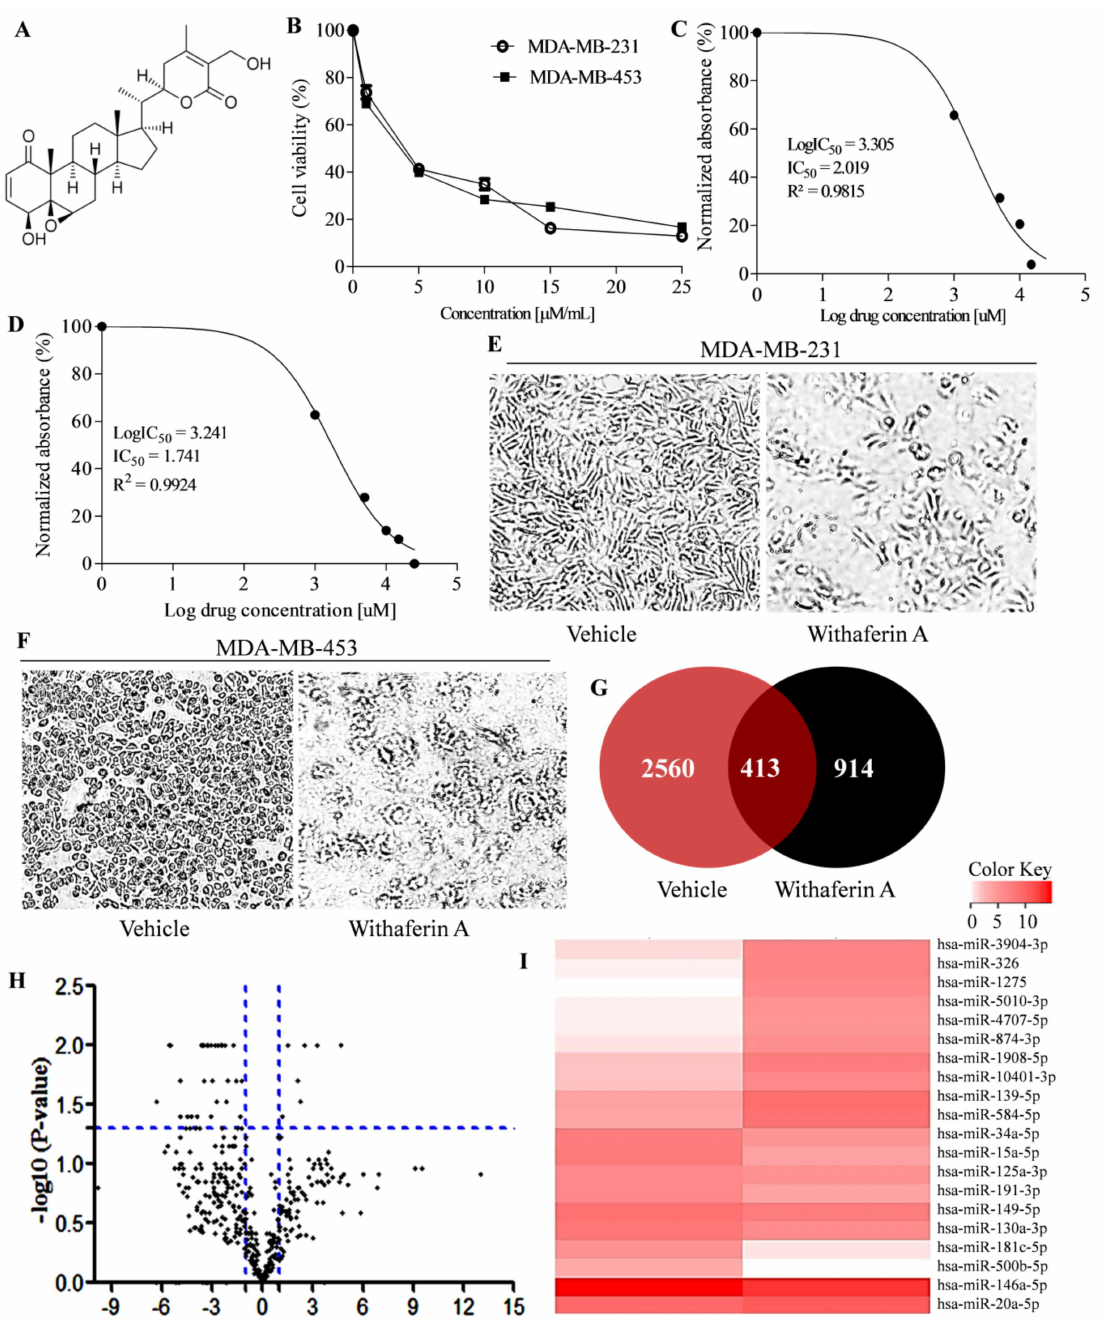
Figure 1. The effect of Withaferin A on the miRNA expression profile in triple-negative cancer cells. ( A ) Chemical structure of Withaferin A adapted from PubChem (PCID 265237) ( B ) Effect of Withaferin A on MDA-MB-231 and MDA-MB-453 cells in 24 h treatment ( C , D ) Calculation of IC 50 concentration in 24h Withaferin A treatment in MDA-MB-231 and MDA-MB-453 cells using regression analysis, respectively. ( E ) Effect of vehicle and Withaferin A treatment on MDA-MB-231 and ( F ) MDA-MB-453 cells morphology at IC 50 concentration in 24h treatment, respectively. ( G ) Venn diagram analysis showing common miRNAs expressed in vehicle- and Withaferin A (IC 50 )-treated MDA-MB-231 cells in 24h exposure. ( H ) Volcano plot showing significant differential expression of miRNAs in Withaferin A (IC 50 )-treated MDA-MB-231 cells in 24h exposure compared to vehicle-treated cells. ( I ) Heatmap showing expression pattern of top twenty differentially expressed miRNAs in Withaferin A (IC 50 )- and vehicle-treated group in 24 h